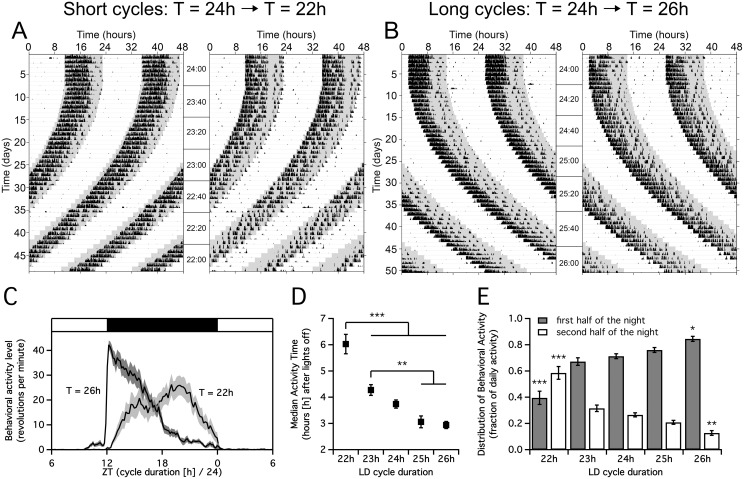
Changes in timing and waveform of behavioral activity during short and long T-cycle durations.A, B. Actograms display running wheel activity of individual mice exposed to gradually shortening (A) or gradually lengthening (B) T-cycles. Data are double plotted. Background color indicates lights on (white) or lights off (grey). Note that as T-cycles progressively shorten, behavioral activity starts later in the night (A) while under lengthening T-cycles, behavior is increasingly confined to the first half of the night (B). C. The average running wheel activity distribution (+/− SEM, shaded area) during a T-cycle duration of 22 hours (T = 22 h, N = 14 animals) or 26 hours (T = 26 h, N = 14 animals). The dark bar above the behavioral activity indicates the night. D. During short T-cycle durations, the median time of behavioral activity is significantly later in the night than under long T-cycles (***P<0.001, **P<0.01). E. The fraction of behavioral activity in the first versus the second half of the dark period. Behavioral activity shifts to the second half of the dark period during short T-cycles, and to the first half of the dark period during long T-cycles (***P<0.001, T = 22 h compared to all other cycle durations, **P<0.01, *P<0.05, T = 26 h compared to T = 23 h and T = 24 h).